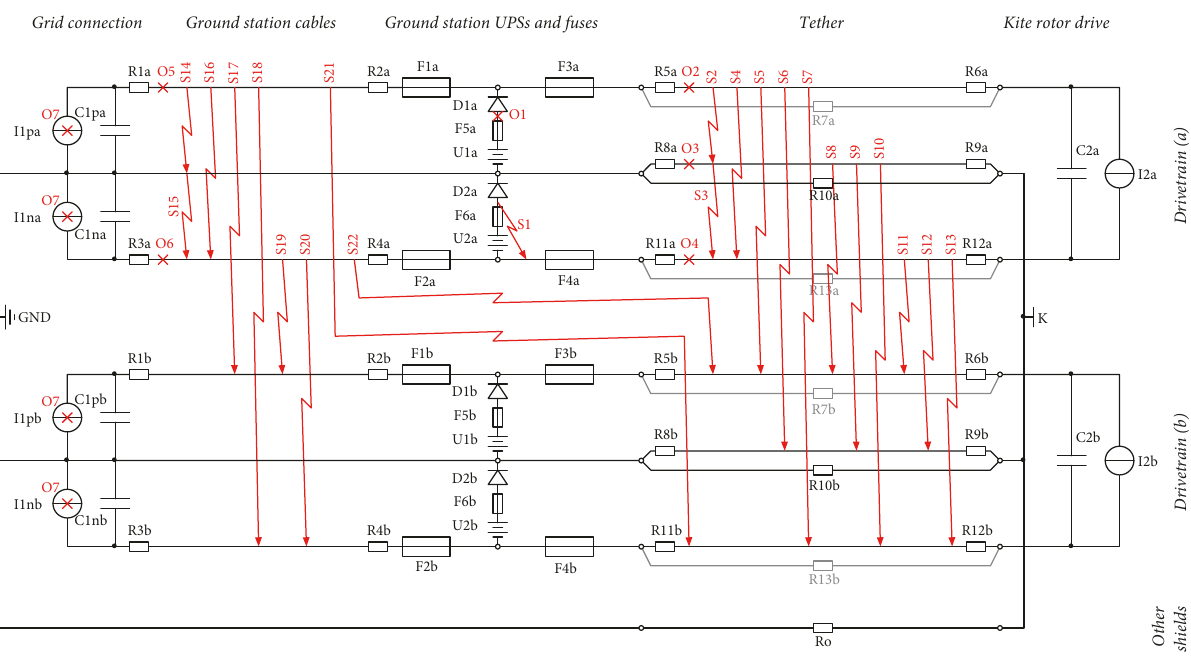
Figure 11: Equivalent circuit diagram of the proposed fuse system and considered faults inside and between two “isolated drivetrains” (a) and (b), where GND is the ground (earth), K is the kite’s frame, I1p# and I1n# are the positive and negative current sources of the power electronic converter(s) on ground closest to the tether, I2# is the current source of the power converter onboard the kite closest to the tether, C# is a (filter) capacitor, R# is a (parasitic) resistance, F# is a fuse, D# is a diode, U# is a UPS voltage source (drawn as battery), short circuit faults are enumerated with S#, and open circuit faults are enumerated with